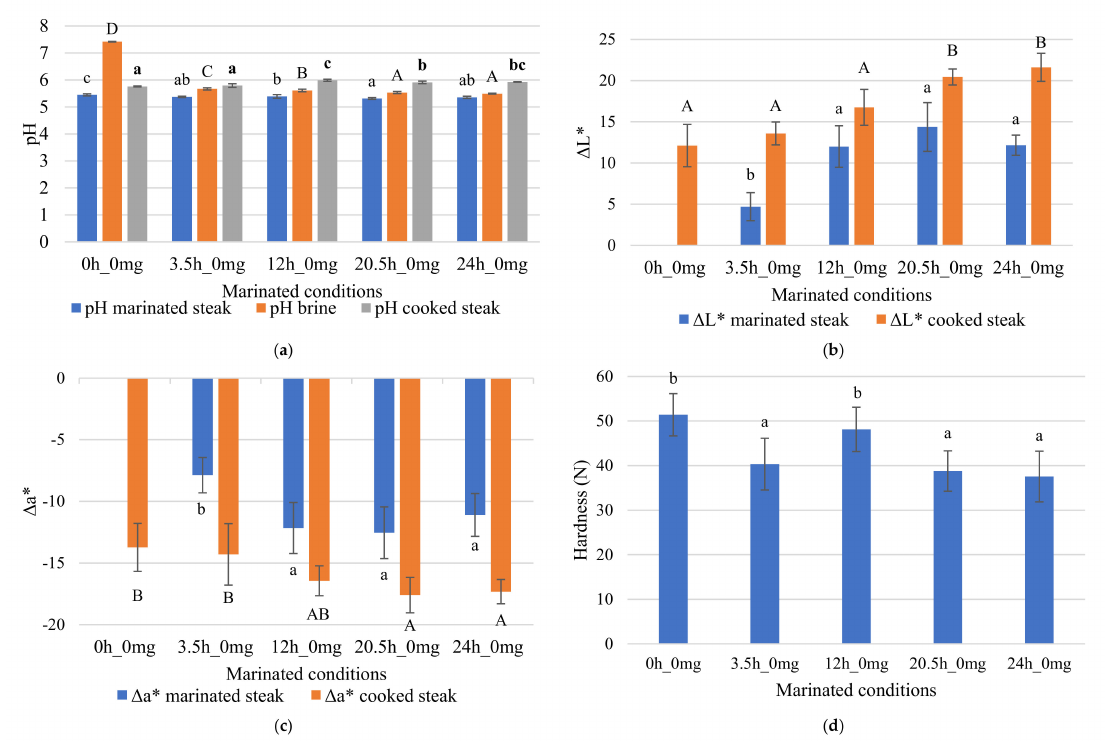
Figure 5. Study of the e ff ect of adding brine on marinated steaks: ( a ) pH, ( b ) ∆ L* color, ( c ) ∆ a* color, and ( d ) hardness. Error bars represent ± standard deviation (pH and color: n = 3 and hardness: n = 20). pH: Di ff erent letters express significant di ff erences between pH marinated steak samples (lower case letters); between pH brine samples (upper case letters); and between pH cooked steak samples (bold lower-case letters). Color: Di ff erent letters express significant di ff erences between color marinated steak samples (lower case letters) or between color cooked steak samples (upper case